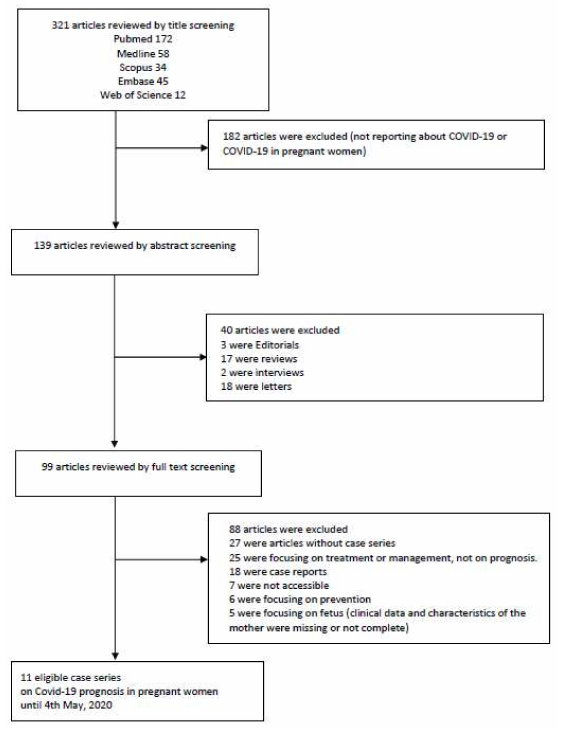
Figure 1. Flow chart of literature